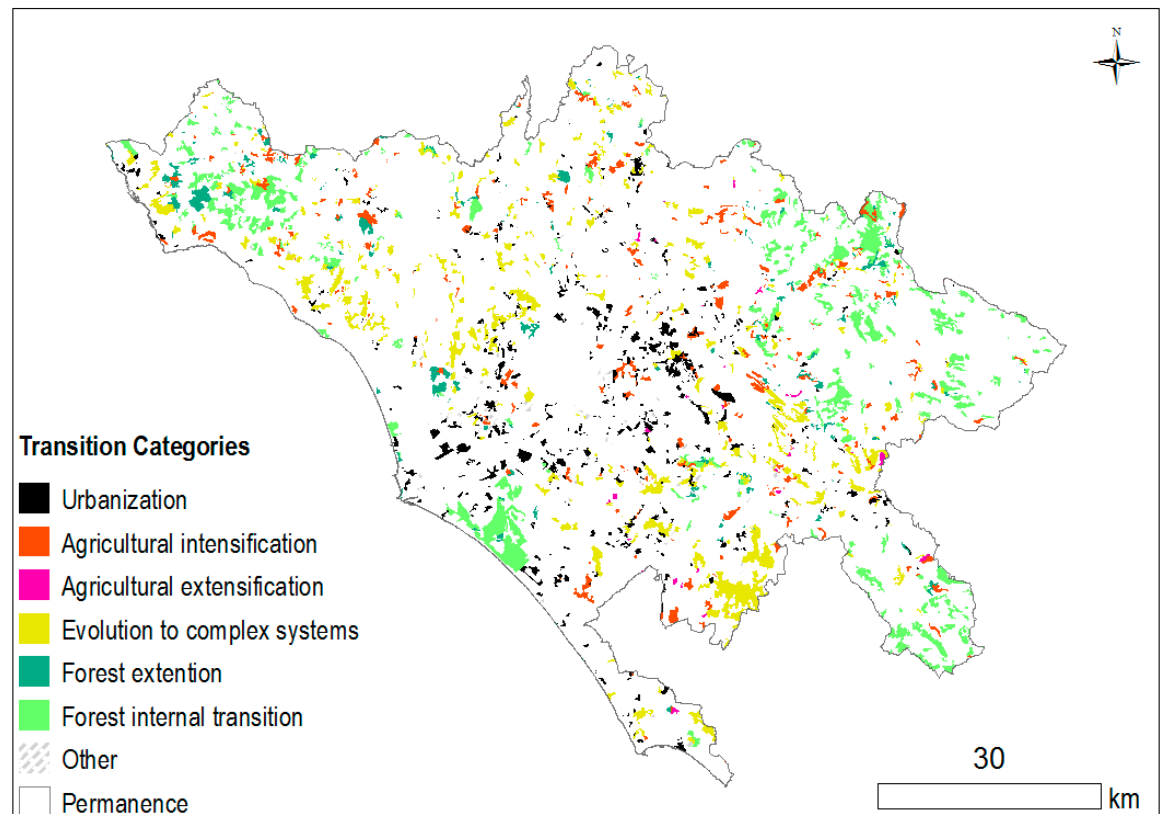
Figure 4. LULCC transition categories map: urbanization (black), agricultural intensification (red), agricultural extensification (pink), evolution to complex systems (yellow), forest extension (green), forest internal transition (light green), other (gray), and permanence (white).